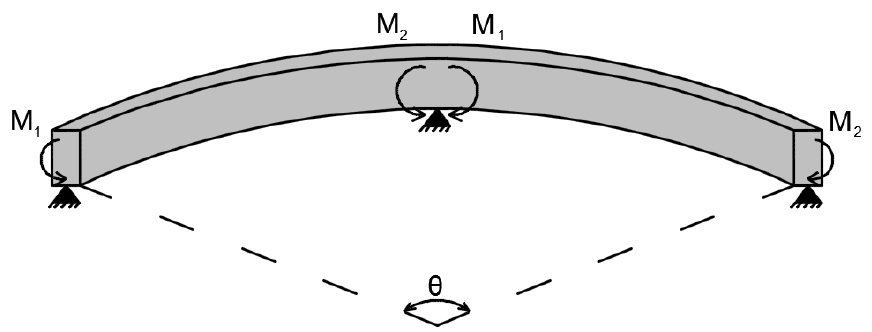
Figure 8. Two-span curved continuous beam.